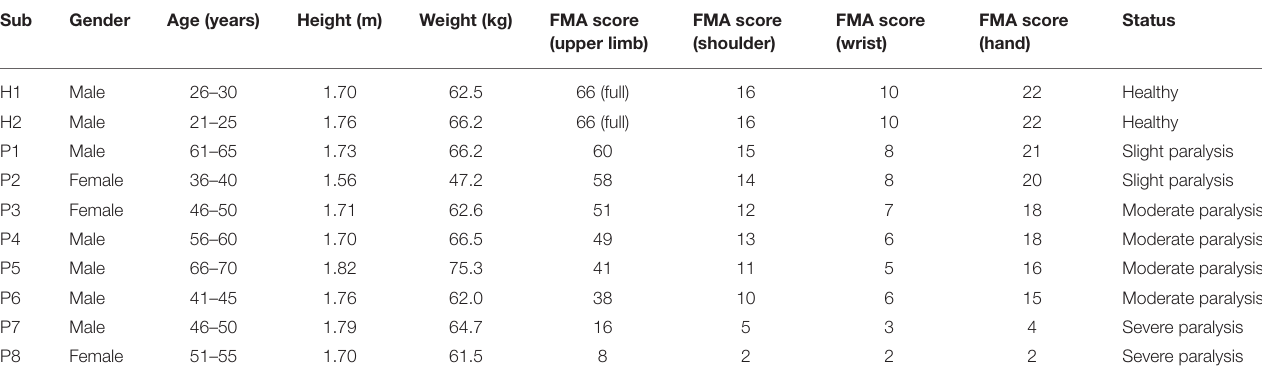
TABLE 3 | Characteristics of the subjects participating in